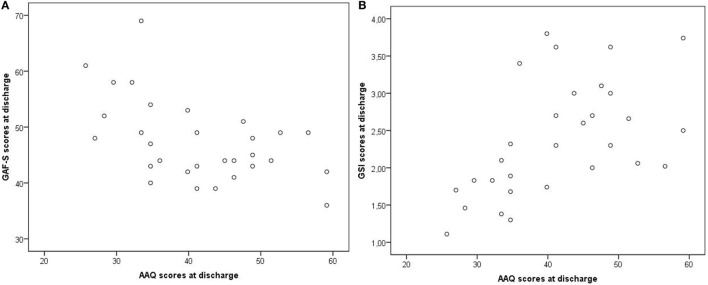
Examples of correlations at discharge: AAQ vs. GAF-S and GSI. AAQ, Acceptance and Action Questionnaire; GSI, Global Severity Index from the Brief Symptom Inventory; GAF-S, Global Assessment of Functioning, symptom subscale. Correlations: (A) AAQ vs. GAF-S, r = −0.52. (B) AAQ vs. GSI, r = 0.54.